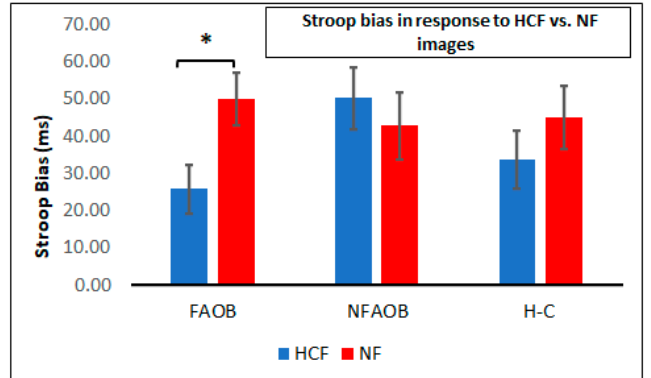
Figure 3. Attention bias following food and nonfood cues. A graphical depiction of mean and SEM of the Stroop bias following HCF and NF images in the FAOB, NFAOB, and H-C participants. * p < 0.05. SEM: standard error of mean. HCF: high-calorie food. NF: nonfood. FAOB: overweight and obese with food addiction. NFAOB: overweight and obese without food addiction. H-C: healthy controls. Nonparametrical permutation tests indicated differences between the three groups in brain potentials in response to food cues. There was an amplitude change induced by the food cues (HCF vs. NF), in the LPPb but not in the LPPa, in the frontal (F = 4.09 ( n = 52) , p = 0.02) and right occipital (F = 3.78 ( n = 52) , p = 0.02) but not in the left occipital ROI (F = 1.40 ( n = 52) , p = 0.26) (Figure 4). Post-hoc contrasts revealed that the FAOB group had a lower food cue-induced amplitude change in the LPPb compared with the NFAOB group, in the frontal ( t = 2.84 ( n = 37) , p = 0.0058) and right posterior ( t = 2.62 ( n = 37) , p = 0.0013) ROI. Neither the FAOB nor the NFAOB groups statistically differed from the H-C group.